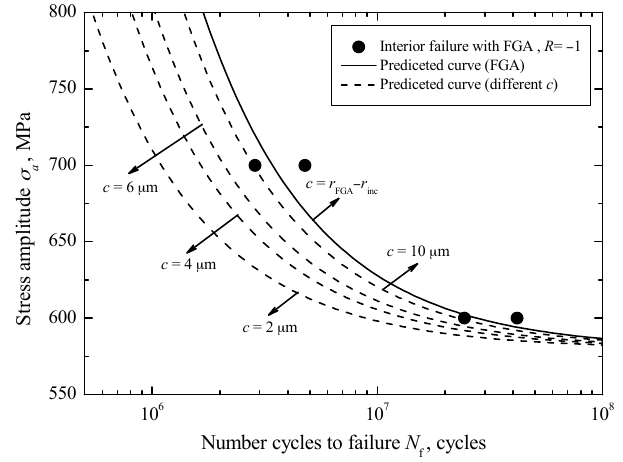
Interior failure with FGA , R = 0 Interior failure with FGA , R = 0.3 Predicted life curve, R =0 (FGA) Predicted life curve, R =0 (different c ) Predicted life curve, R = 0.3 (FGA) Predicted life curve, R =0.3 (different c )